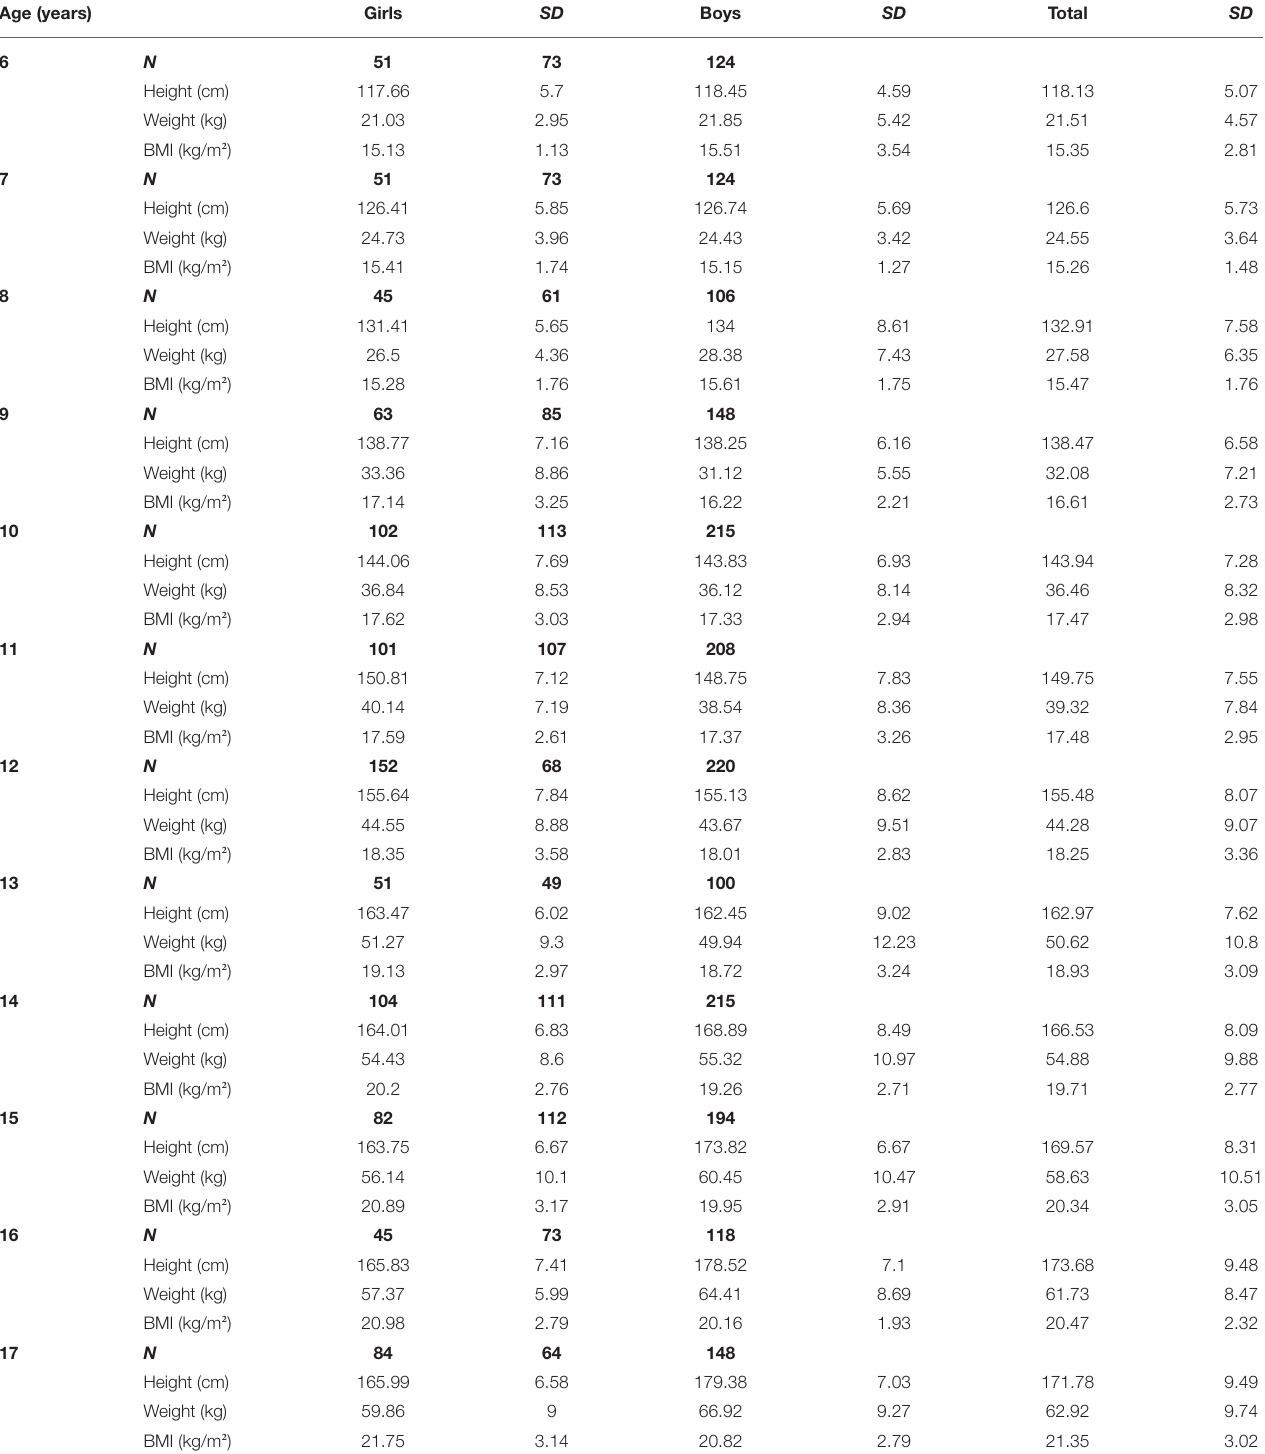
TABLE 1 | Mean and standard deviation (SD) for the anthropometric variables of the participants within the various age groups. Age